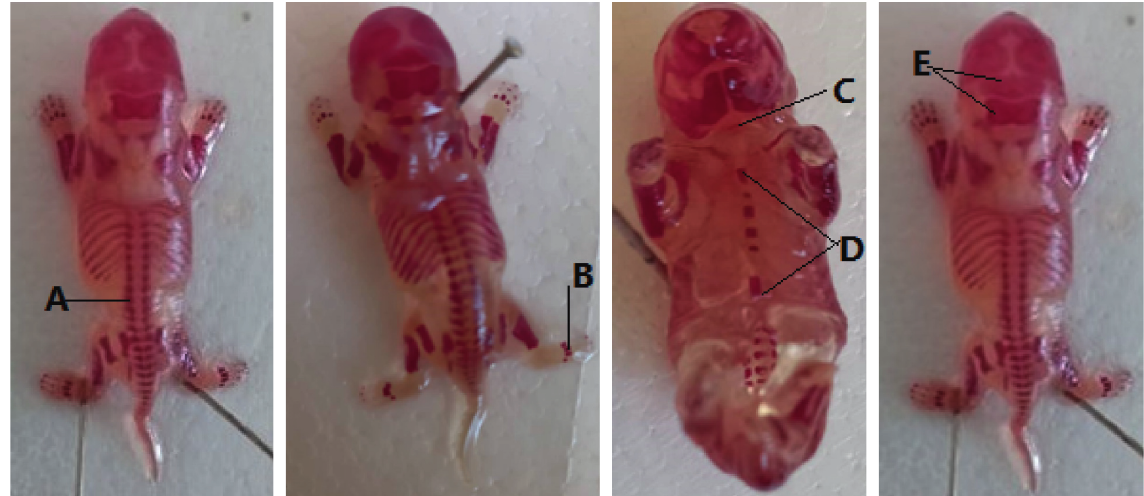
Figure 5: Alizarin red-stained rat fetuses showing different ossification centers. A: vertebrae, B: metatarsal, C: hyoid, D: sternebra, and E: supraoccipital and